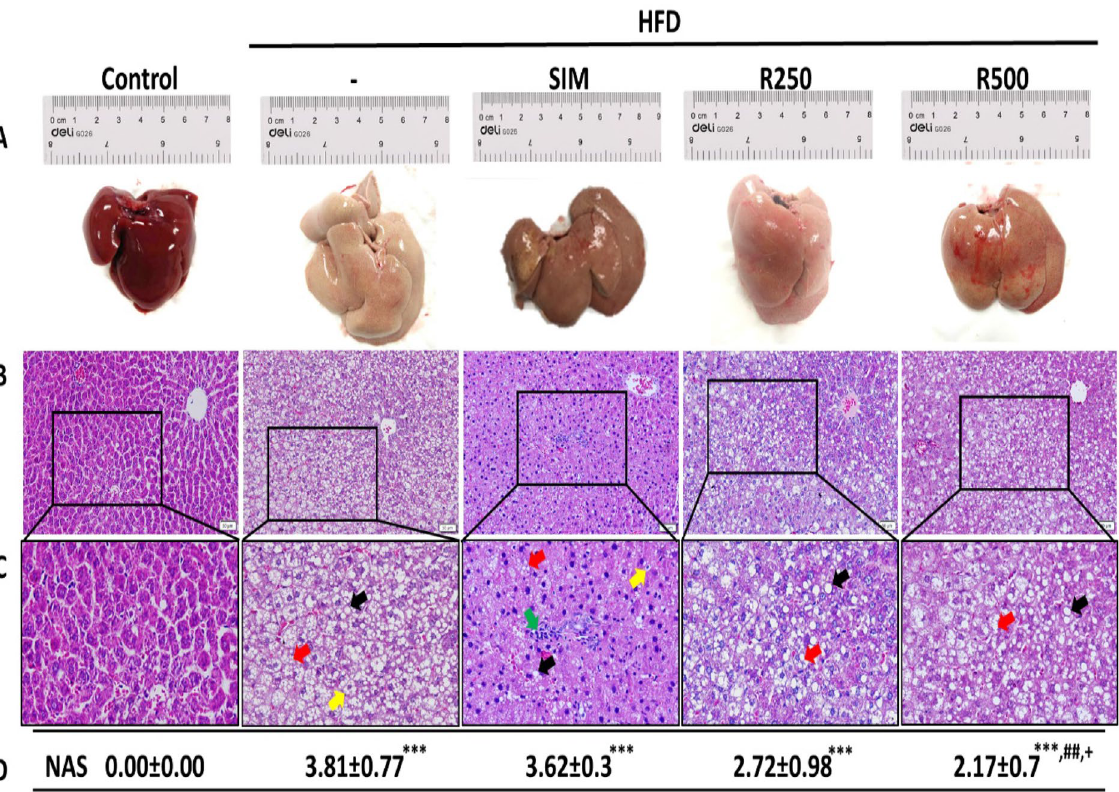
Figure 2. Effect of roselle extract on hepatic steatosis in rats. Rats were fed with normal diet (control), high fat diet (HFD), high fat diet + simvastatin (HFD + SIM), high fat diet + 250 mg/kg BW of roselle extract (HFD + R250), and high fat diet + 500 mg/kg BW of roselle extract (HFD + R500). ( A ) Liver specimens from rats in each group are shown. ( B ) Liver sections with hematoxylin and eosin (H&E) staining (× 200). Scale bars = 50 μm. ( C ) Enlargement areas of liver sections with H&E staining; micro-vesicular steatosis (red arrow), macro-vesicular steatosis (black arrow), lobular inflammation (green arrow), and hepatic ballooning (yellow arrow). ( D ) Non-alcoholic fatty liver disease activity scores (NAS) were evaluated. The data represent the average NAS ± SD of 5 to 7 individual rats per group. NAS were examined in 5 different areas per slide with 2 slides per rat. Statistical analysis was performed with one-way ANOVA followed by Tukey’s post hoc test. The mean difference was significant compared with the control group (*** P < 0.001), HFD group ( ## P < 0.01) and the HFD + SIM group ( + P <